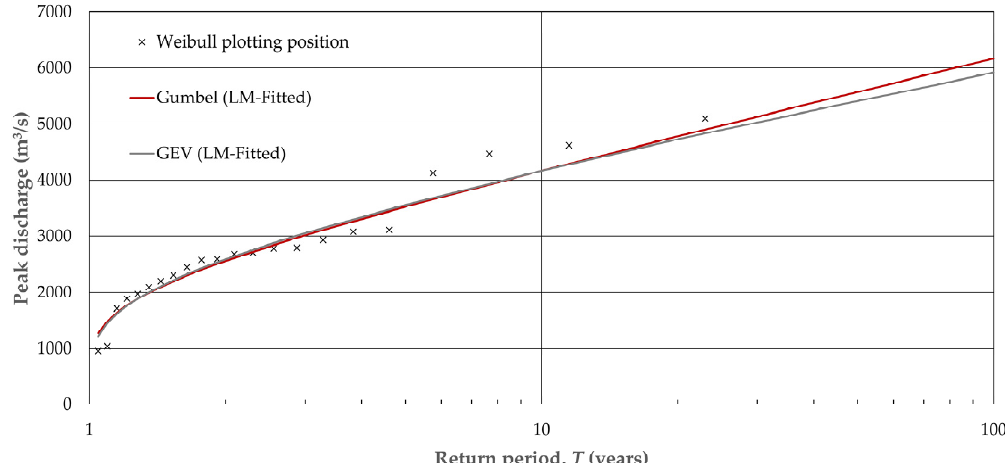
Figure 6. Distribution function plot for Annual Maxima Series (AMS) and Gumbel and GEV fitted distributions (LM—Linear Moments).